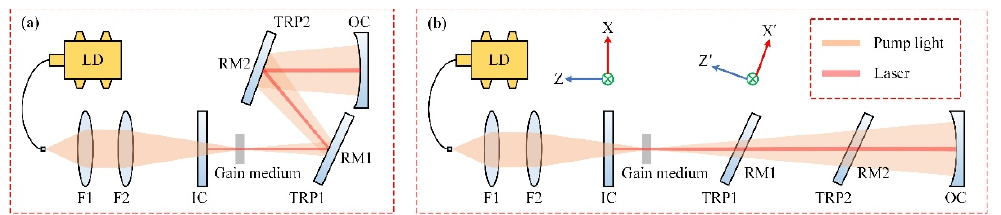
Figure 1. Configuration of the mode-tunable vortex laser.